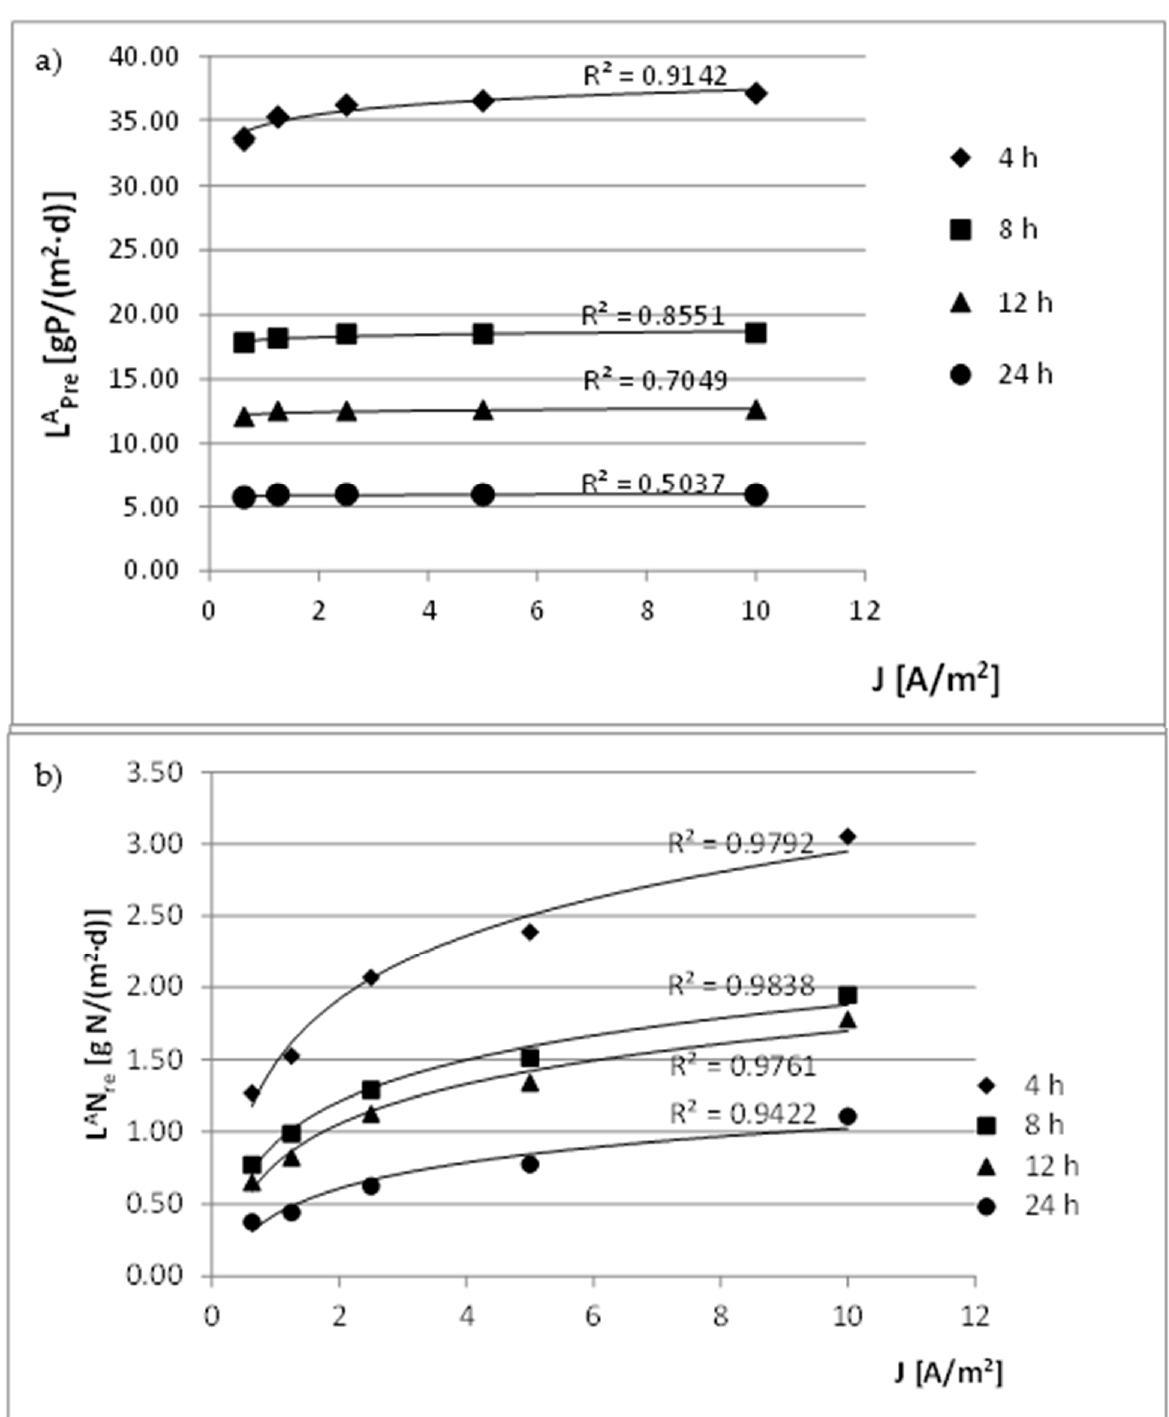
Figure 3. The influence of current density and HRT on the removed load per day (L A ) in the electrobiological rotating disc contactor (REBDC): ( a ) Phosphorus (L A P re ); ( b ) total nitrogen (L A N re ).